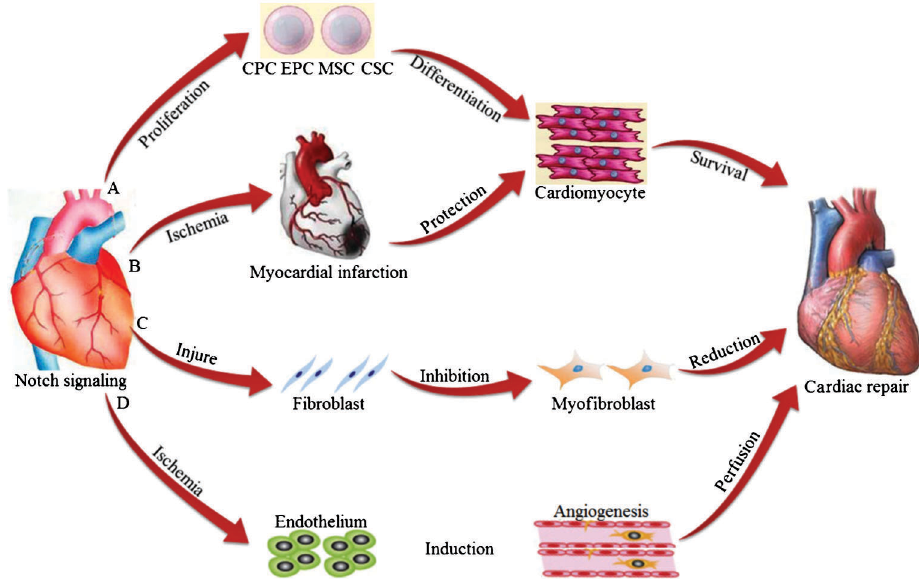
Figure 4. Cardiac repair mediated through Notch signaling. A , Notch signaling promotes stem cell differentiation into cardiomyocytes. B , Notch signaling has protective effects on the ischemic myocardium. C , Notch signaling negatively regulates CMT. D , Notch signaling induces angiogenesis. CMT: cardiac fibroblast to myofibroblast transformation; CPC: cardiac progenitor cell; EPC: endothelial progenitor cell; MSC: mesenchymal stromal cell; CSC: cardiac stem